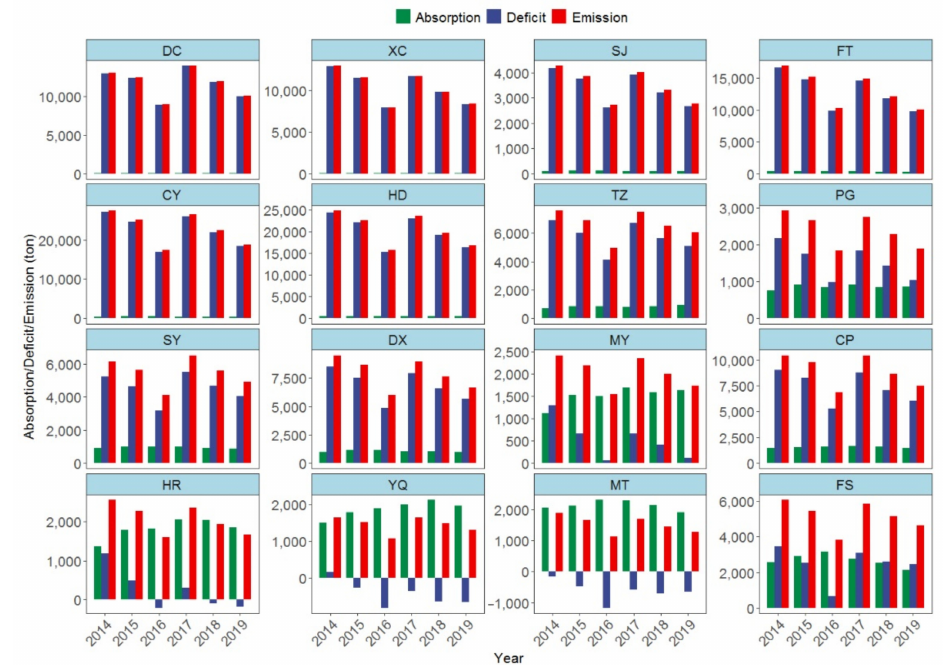
Figure 7. Annual NO 2 absorption, deficit, and emission in 16 districts. (Green bars: average annual NO 2 absorption. Red bars: annual NO 2 emission. Blue bar: purification